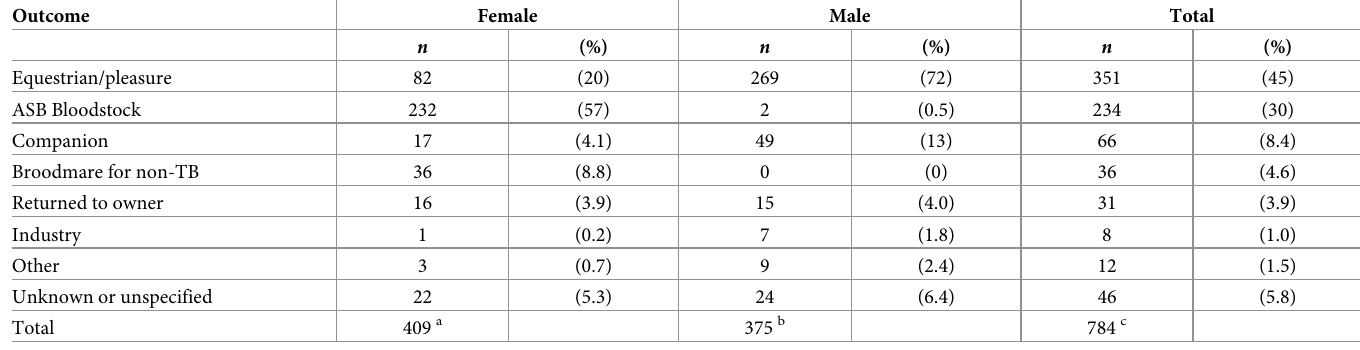
Table 2. Post-racing activities undertaken by survey horses reported as retired in the 2017–2018 Australian Thoroughbred racing season ( n =